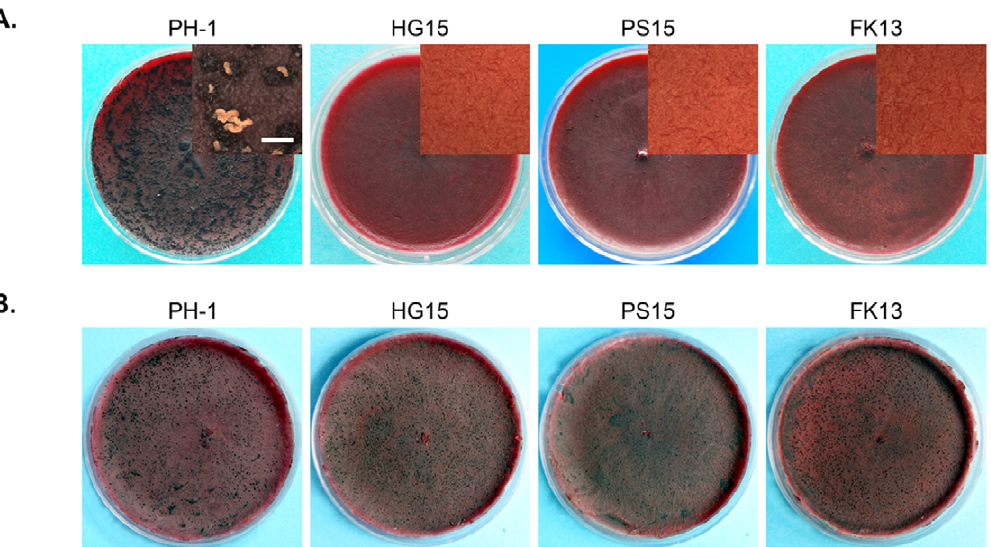
Figure 4. Defects of the Fghog1 , Fgpbs2 , and Fgssk2 mutants in sexual reproduction. A . Self-crossing cultures of the wild type (PH-1) and the Fghog1 (HG15), Fgpbs2 (PS15), and Fgssk2 (FK13) mutants. Fertile perithecia with cirrhi were only observed with the wild type. B . Carrot agar cultures of the mat2 mutant fertilized with Fghog1 , Fgpbs2 , and Fgssk2 mutants. All the mutants retained male fertility. The close-up views were taken under a dissecting microscope.